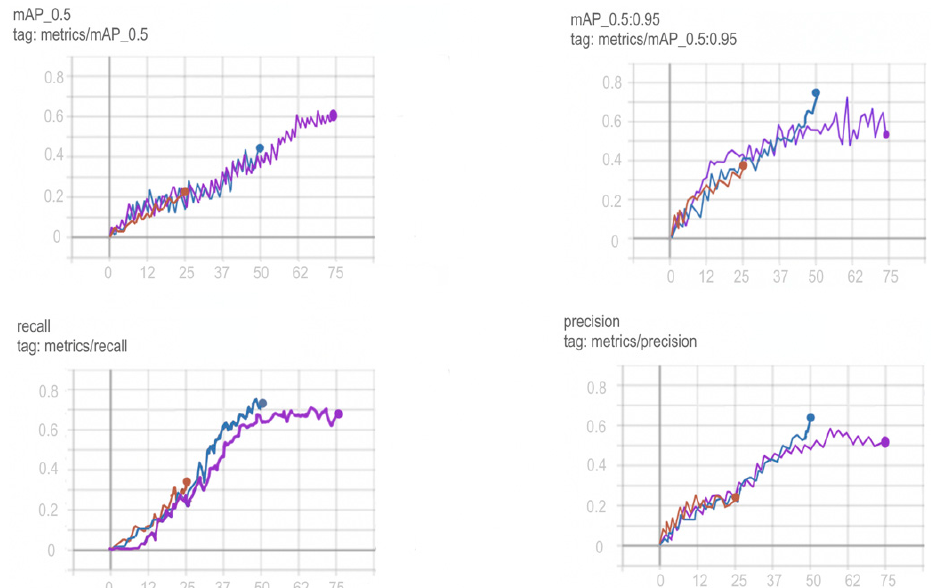
in Figure 13. Figure 12. Visualization matrix of errors (validation sample). Figure 12. Visualization matrix of errors (validation sample).